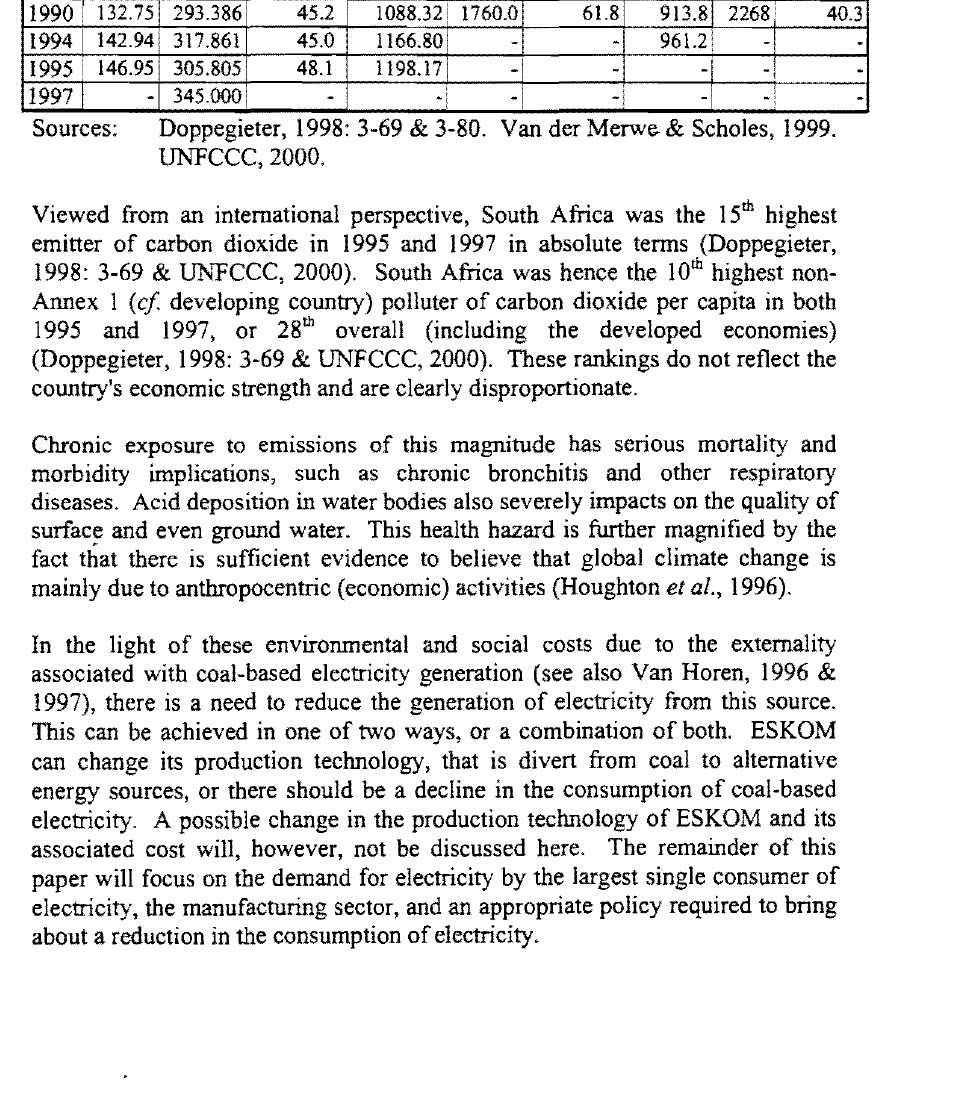
Carbon dioxide, Sulphur dioxide and Nitrogen emissions in South Africa: 1990, 1994 and 1995 CO2 (Million tonnes) , S02 (Thousand